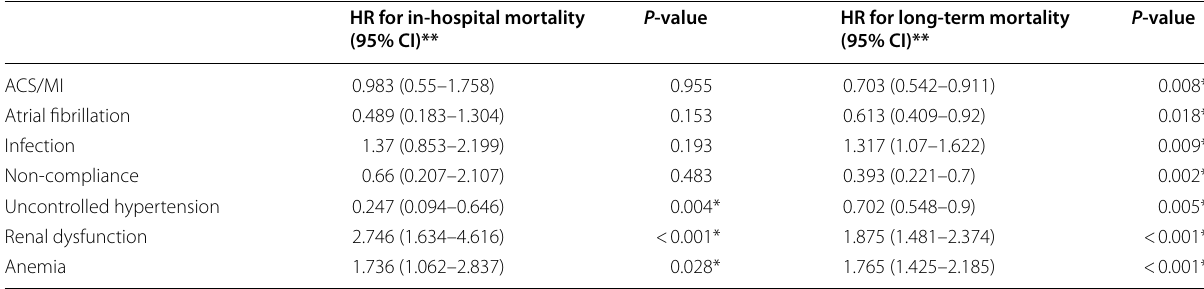
HR Hazard ratio; 95% CI 95% confidence interval *Significant; **Adjusted for age, gender, HF history, AF history, and HF status